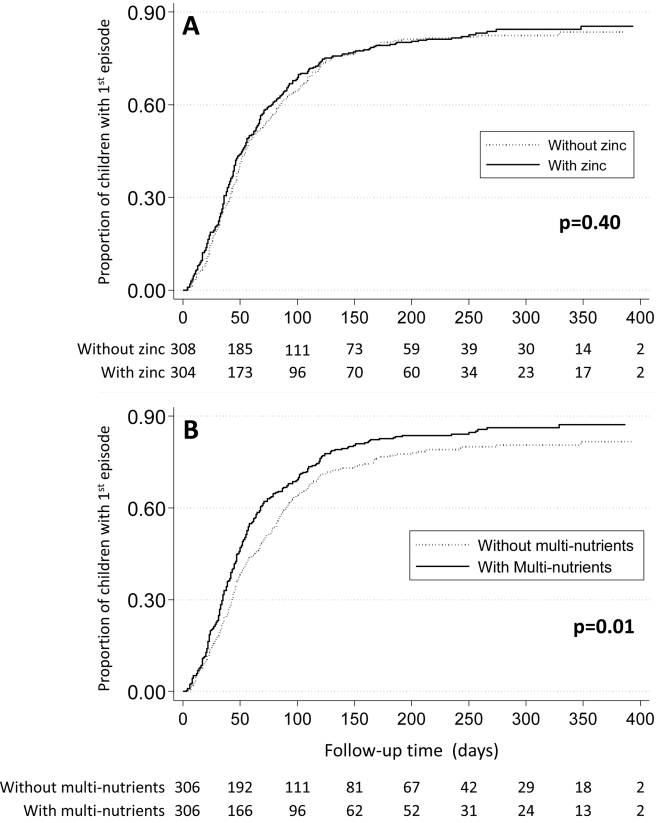
Effect of zinc (panel A) or multi-nutrients (panel B) on time to first malaria episode.Marginal group comparisons (Kaplan-Meier analysis), with p-values obtained by Tarone-Ware test. Values below each panel indicates the number of children at risk.